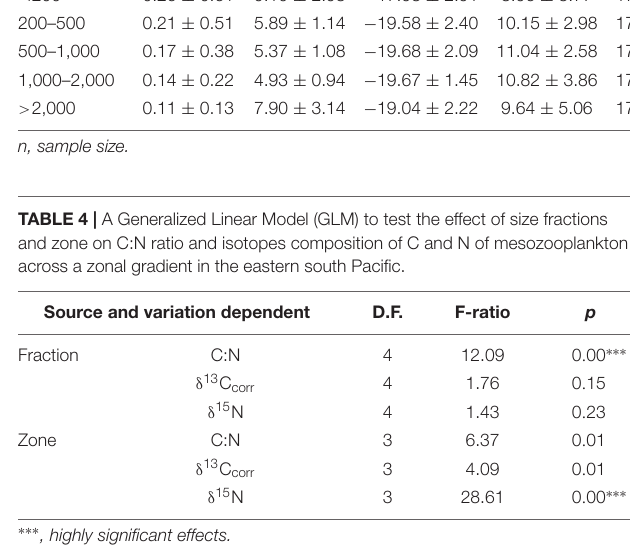
∗∗∗ , highly significant